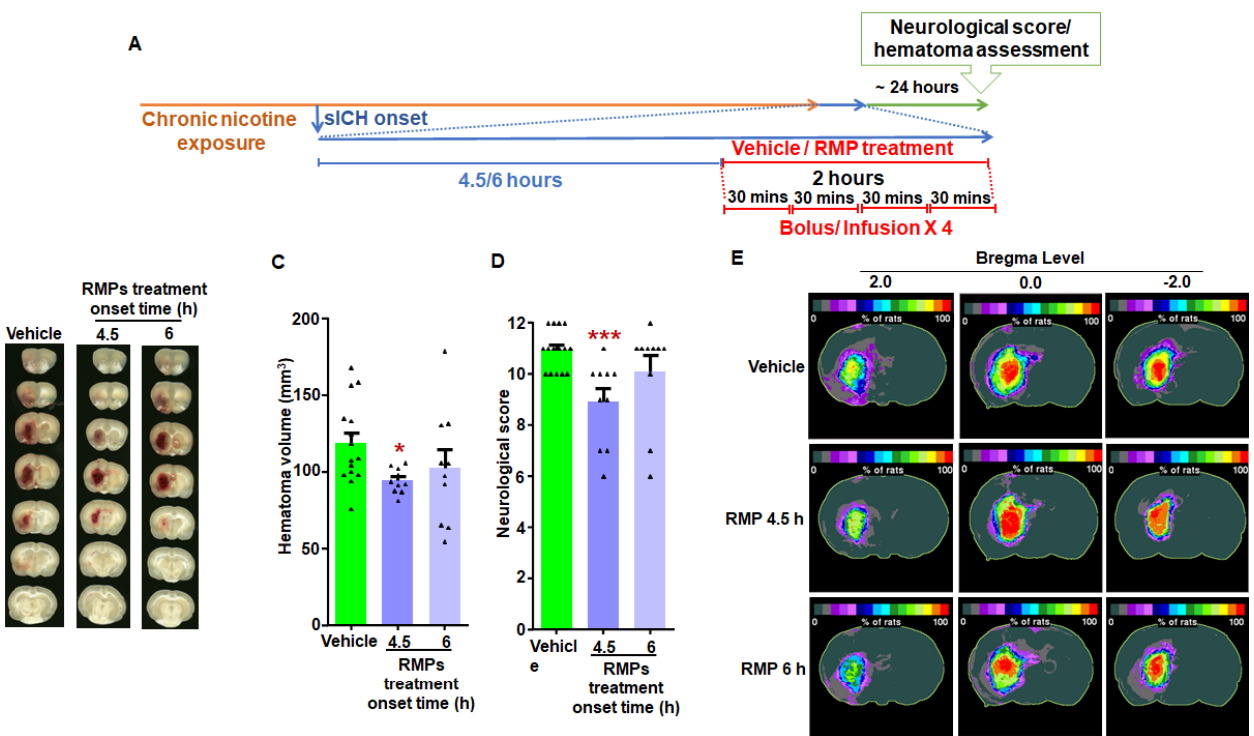
Figure 3. The effect of two different RMP treatment time points on hematoma expansion post-sICH in nicotine-exposed male rats: ( A ) representation of experimental design; ( B ) example images of brain scans showing mean hematoma volume; ( C ) mean hematoma volume data; ( D ) mean neurological score data; and ( E ) hematoma frequency maps at 3 coronal levels (bregma +2.0 mm, 0.0, and − 2.0 mm). The top row depicts the hematoma frequency maps of vehicle-treated rats, the middle row demonstrates hematoma frequency maps of 4.5 h post-sICH RM-treated rats, and the bottom row shows the hematoma frequency maps of 6 h post-sICH RMP-treated rats. N = 15 for vehicle group, and n = 10 for RMP-treated groups. * p < 0.05 and *** p < 0.005 vs. vehicle group.